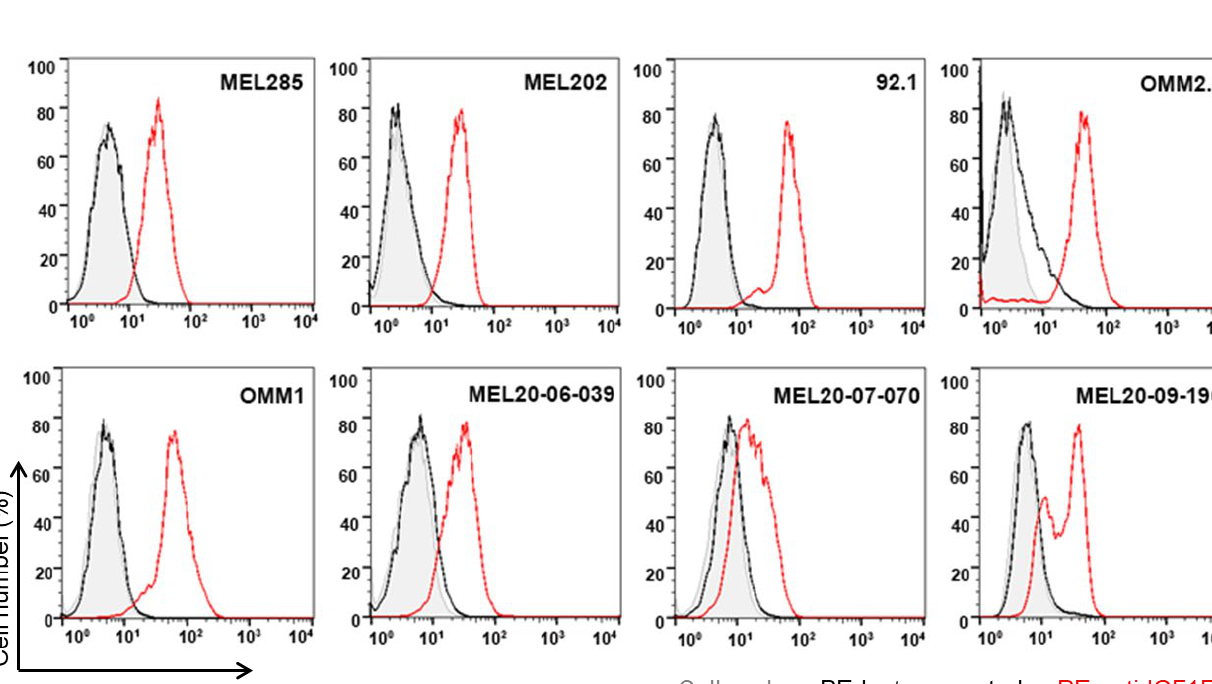
Figure 1. Expression of IGF-1R in UM tumors and cell lines. ( A ) The IGF-1R mRNA expression levels in tumor and normal tissues were compared in 33 cancer (red dots) and corresponding normal (green dots) tissues through TCGA database analysis. The expression in UM is indicated by an arrow. ( B ) RT-PCR analyses showing IGF-1R mRNA levels in 10 different UM cell lines. ( C ) Western blot analysis showing IGF-1R activation/induction in UM cell lines with 75 ng/mL of IGF-1 treatment for 10 min. ( D ) Western blot analysis for IGF-1R levels using IGF-1R antibody shows higher expression of IGF-1R protein in UM cell lines (92.1 and Mel270) vs. non-cancerous melanocytes, keratinocytes and fibroblasts. ( E ) FACS histogram plots showing cell surface expression of IGF-1R in the UM cell lines (Mel285, Mel202, 92.1, OMM2.3, OMM1, MEL20-06-039, MEL20-07-070 and MEL20-09-196) stained with IGF-1R antibody (red lines). The isotype control is represented by the black lines in the FACS histograms, and these experiments were repeated